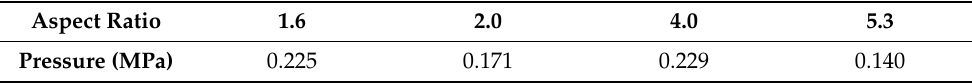
Table 3. Applied pressure (buckling phenomenon inclusive) depending on aspect ratio.